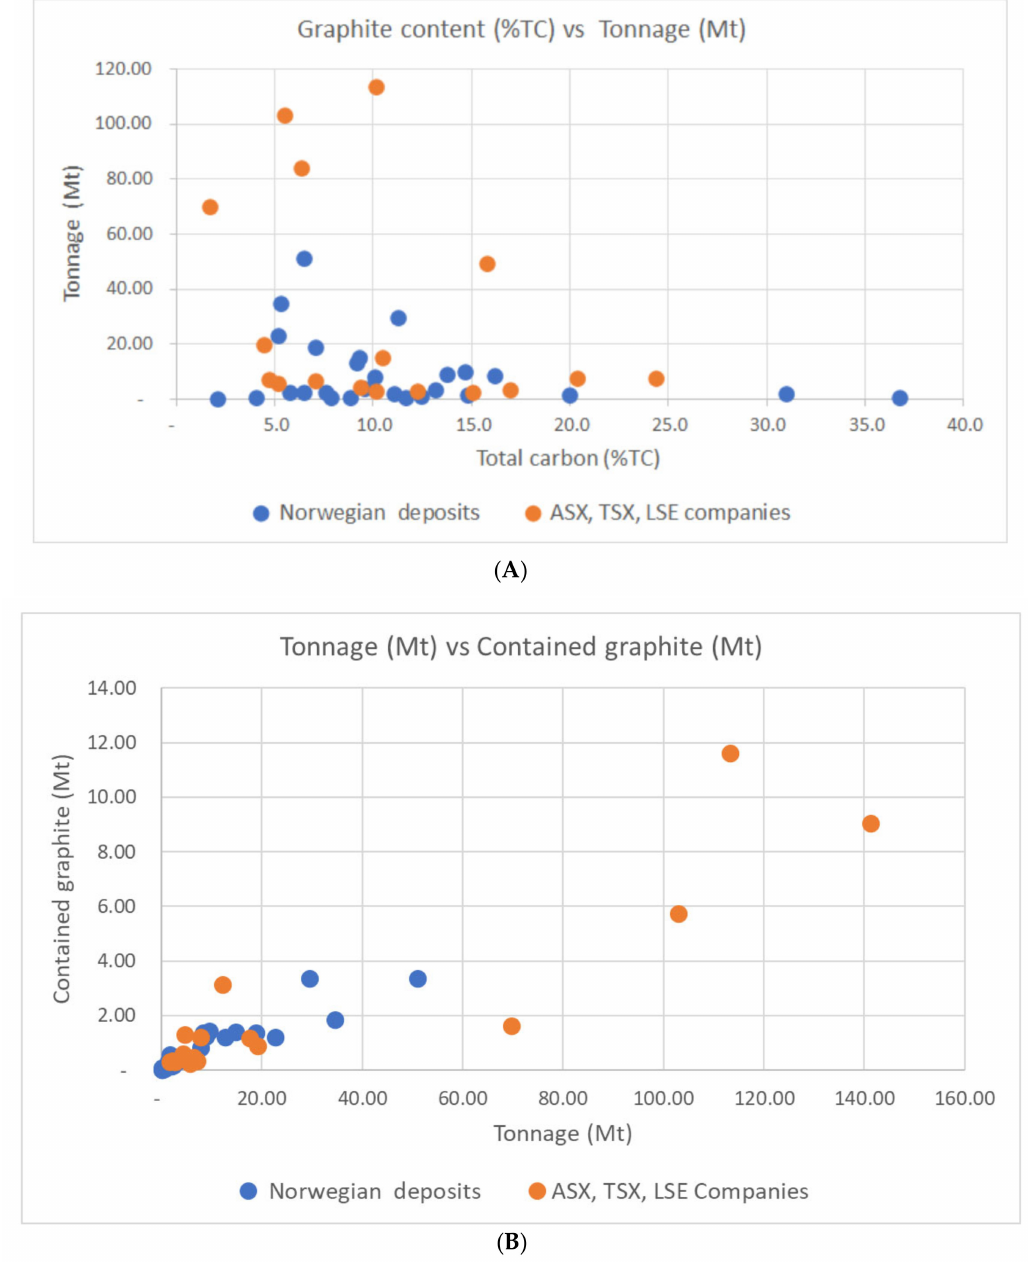
Figure 9. Comparison of graphite content (% TC), tonnage ( A ) (Mt), and contained graphite between ( B ) North Norwegian graphite occurrences and deposit data from companies listed on ASX, TSX, and LSE stock exchanges (see supplementary